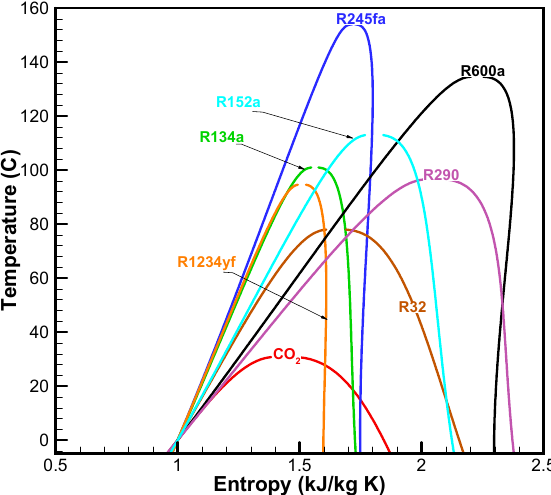
Figure 24. Thermodynamic characteristics curve of refrigerants.